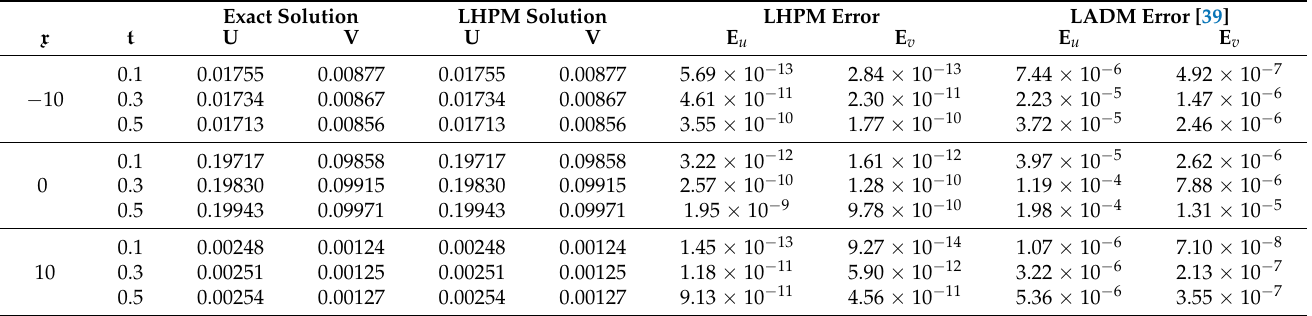
Table 1. Comparison of LADM and LHPM errors for Example 1 when β = 1, α = 1 and η = a = 0.5. Here, E u and E v represents errors of U and V ,